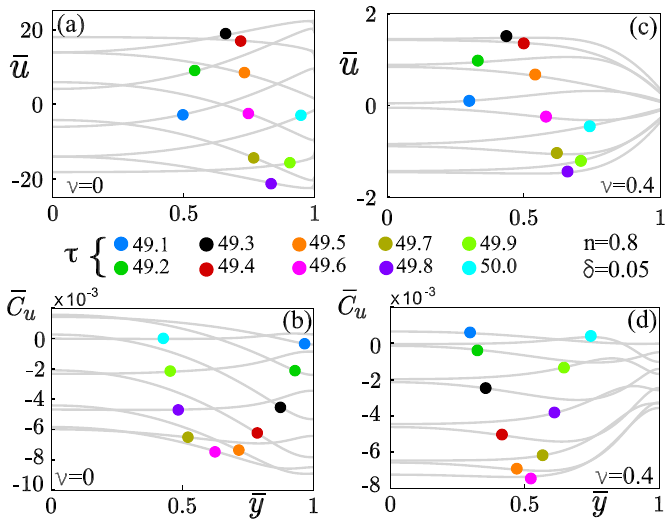
Figure 7. ( a , c ): Velocity profiles ¯ u across the microchannel at one period of oscillation. ( b , d ): Distribu- tion of the convective concentration ¯ c u across the microchannel due to the hydrodynamic in ( a , c ),